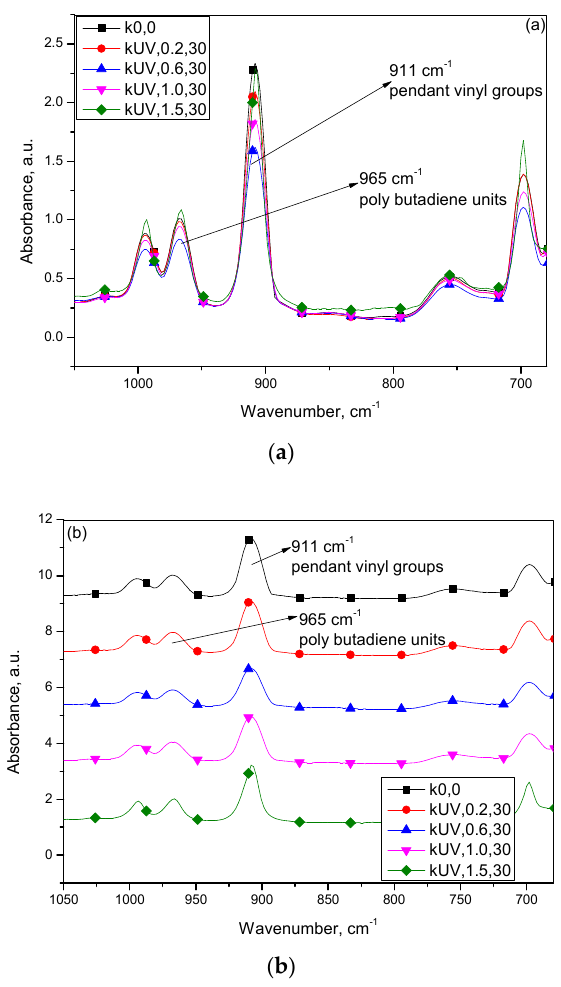
Figure 8. Un-subtracted spectra of the control sample and selected 30 s irradiated samples ( a ) superimposed and ( b ) the spectra stacked by Y offsets.